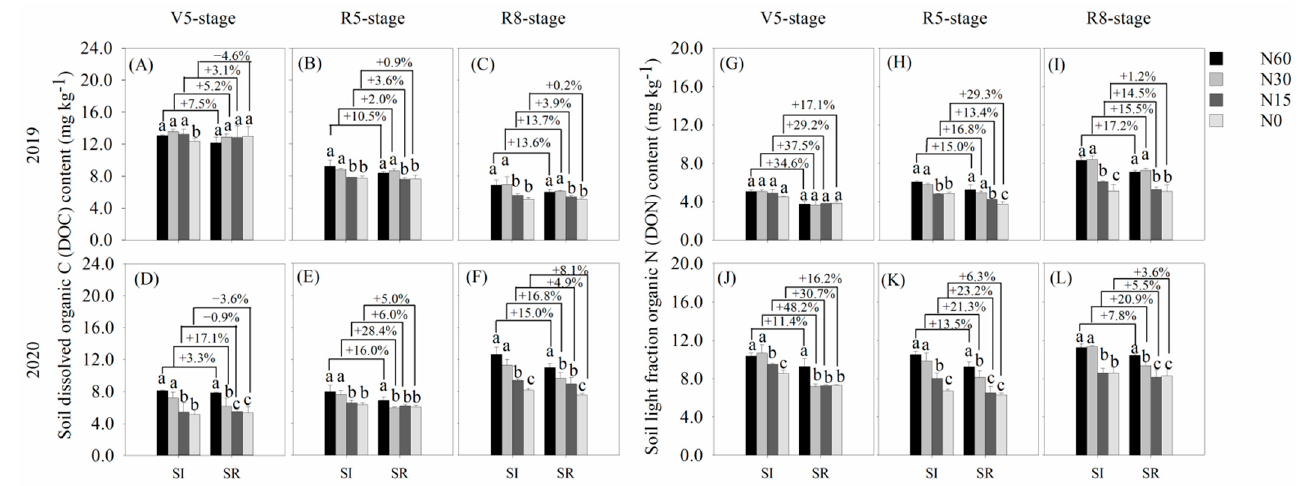
Figure 6. Soil dissolved organic carbon and nitrogen at the different soybean growth stages. ( A ) DOC content at the V5 stage of soybean in 2019, ( B ) DOC content at the R5 stage of soybean in 2019, ( C ) DOC content at the R8 stage of soybean in 2019, ( D ) DOC content at the V5 stage of soybean in 2020, ( E ) DOC content at the R5 stage of soybean in 2020, ( F ) DOC content at the R8 stage of soybean in 2020, ( G ) DON content at the V5 stage of soybean in 2019, ( H ) DON content at the R5 stage of soybean in 2019, ( I ) DON content at the R8 stage of soybean in 2019, ( J ) DON content at the V5 stage of soybean in 2020, ( K ) DON content at the R5 stage of soybean in 2020, ( L ) DON content at the R8 stage of soybean in 2020. In each panel, different lower-case letters “a–c” indicate significant differences under different N application rates within the same straw treatment (LSD, p < 0.05). Same lower-case letters indicate no significant differences under different N application rates within the same straw treatment (LSD, p < 0.05). Data were shown as mean ± S.D. ( n = 3). The values indicate the change in SI relative to SR, and “+” and “ − “ indicate increasing and decreasing, respectively. SI,